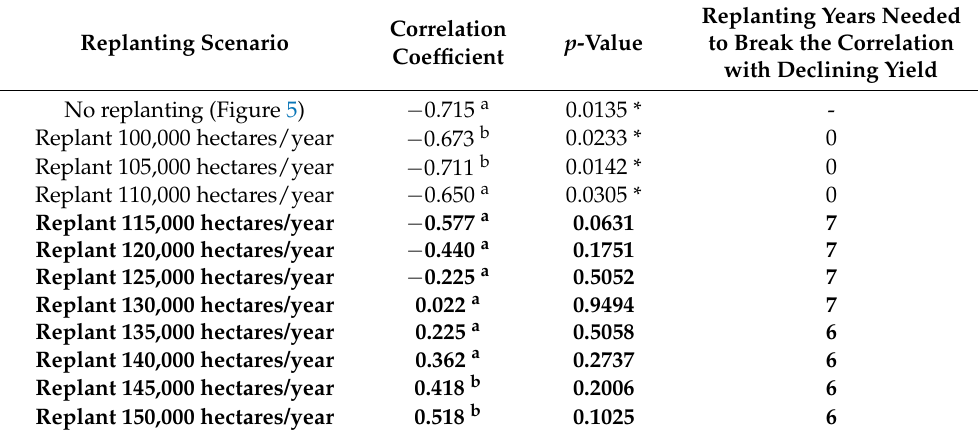
Table 4. Correlations between aged area and FFB yield from 2009 to 2019 (refer to Appendix A, Table A1 for further